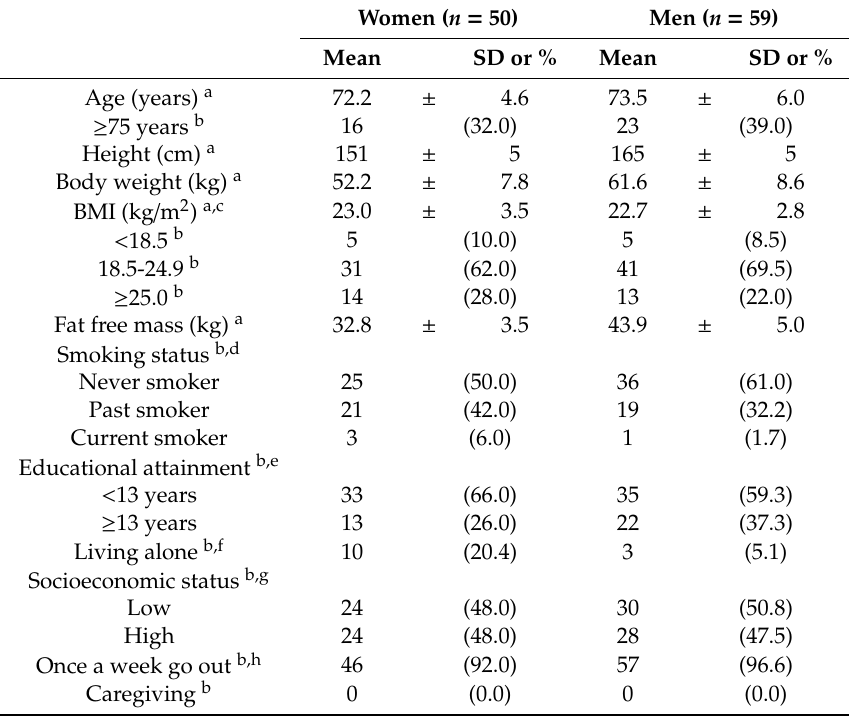
Table 1. Characteristics of study participants according to sex